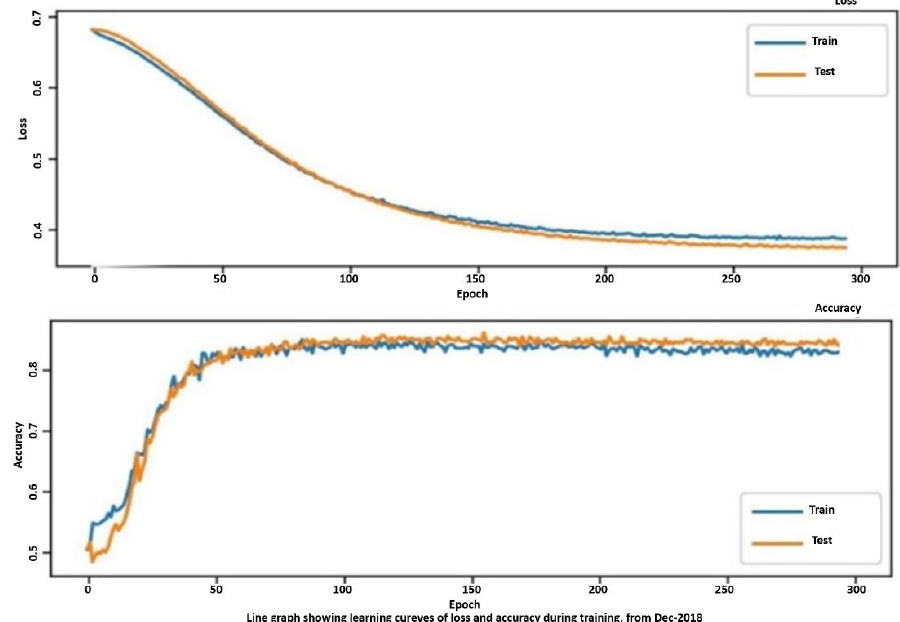
Figure 12. Accuracy vs. long epoch and loss illustration in April 2019.